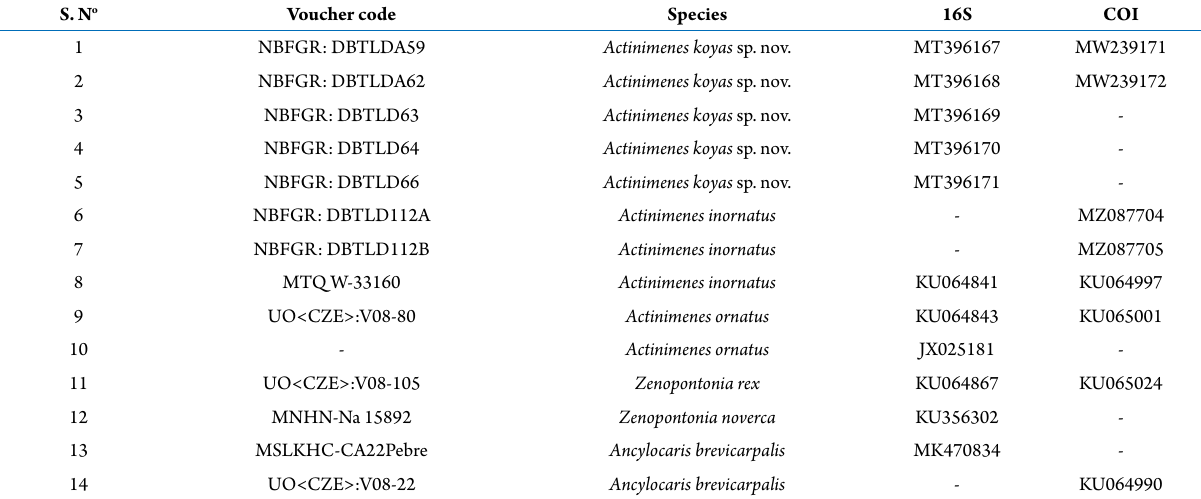
Actinimenes koyas sp.